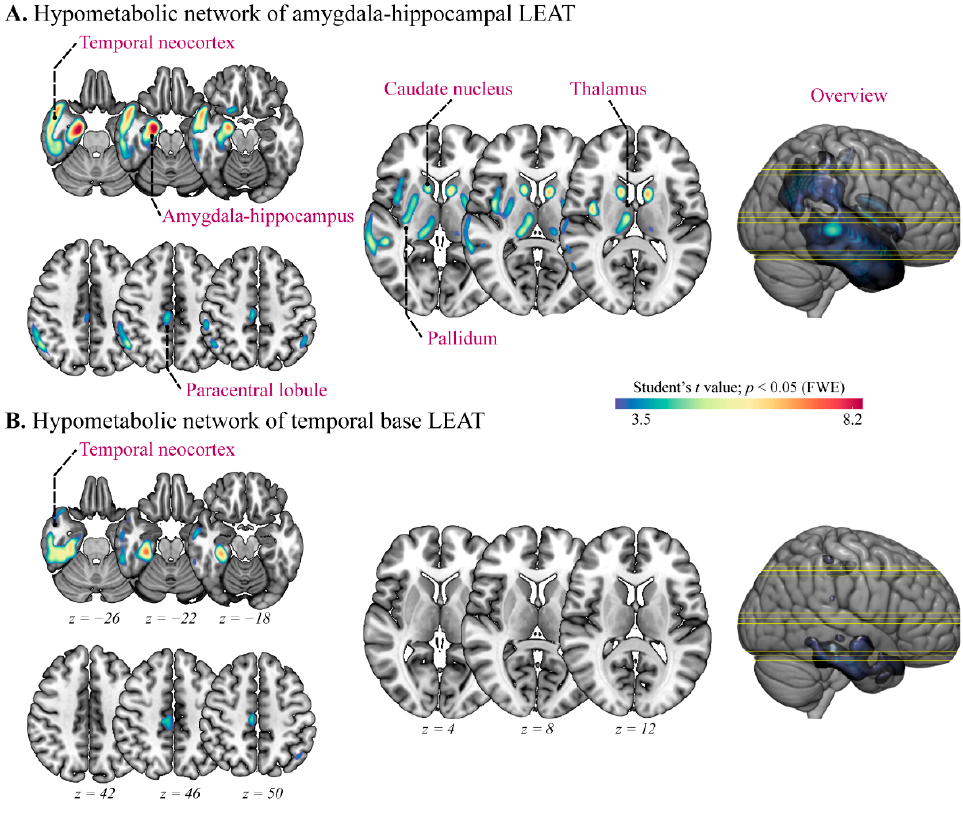
Figure 3. Subgroup analysis of metabolic alteration in mesial temporal lobe long-term epilepsy- associated tumors (LEAT). ( A , B ) Voxel-based t statistical parametrical map demonstrated the widespread hypometabolic networks of amygdala–hippocampal and temporal base LEAT groups, respectively. FWE: family-wise error.